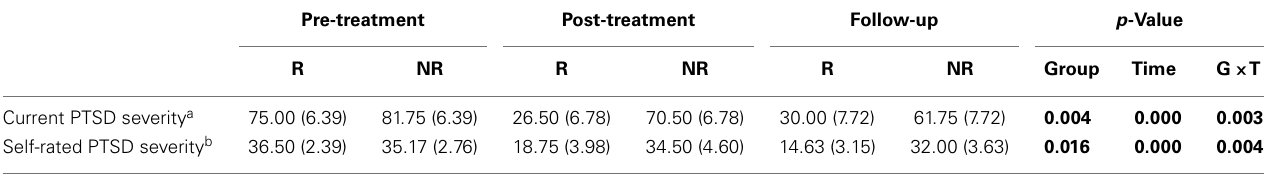
Table 2 | Interview and self-report measures at before and after treatment and at 12-week follow-up in Responders (R) and Non-responders